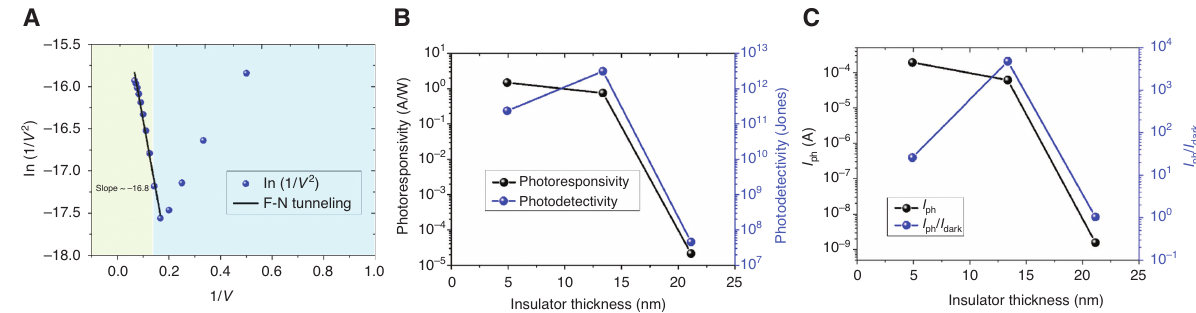
Figure 3: F-N fitting for the photoresponse characteristics, with the dependence of photoresponsivity and photodetectivity for different insulator thicknesses. (A) ln( I ( V )/ V 2 ) − 1/ V curve and Fowler-Nordheim fitting in the positive drain voltage regime. (B) Dependence of photoresponsivity and photodetectivity with different Al O thicknesses. The thickness of the tunneling layer is 4.91 nm, 13.36 nm and 21.12 nm, respectively. (C) 2 3 The photocurrent and I / I ratio with respect to Al O ph dark 2 3